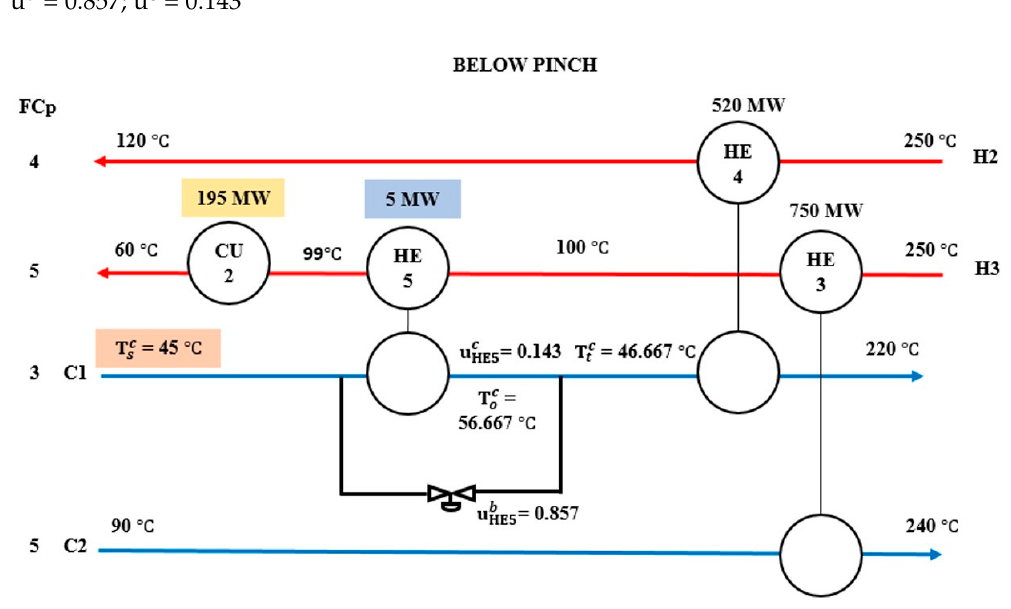
Figure 8. HEN design with T S increased for cold stream below the pinch.